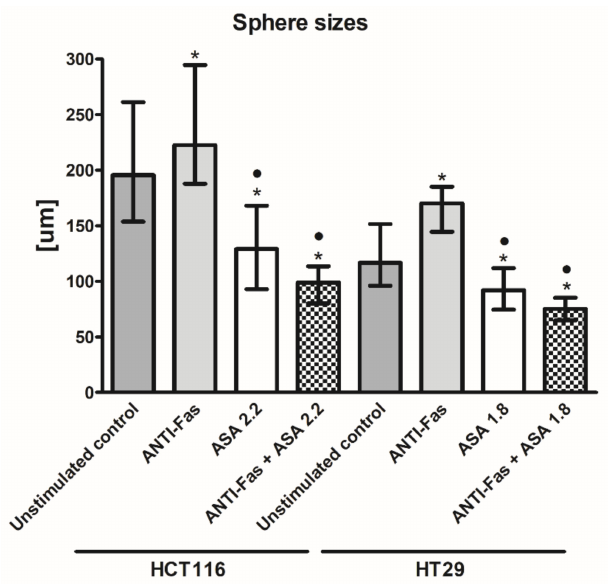
Figure 1. Sizes of colonospheres. Colonospheres were formed from HCT116 or HT29 cells following 10-day incubation with agonistic anti-Fas antibody (200 ng/mL) and/or aspirin (ASA) (2.2 mM or 1.8 mM for HCT116 or HT29, respectively). Statistically significant differences were assessed by Kruskal-Wallis test followed by Dunn’s test as a post hoc procedure. Bars and whiskers represent median ± interquartile range (* p < 0.05 vs control unstimulated cells, • p < 0.05 ASA vs ASA/anti-Fas antibody, n = 50–60).